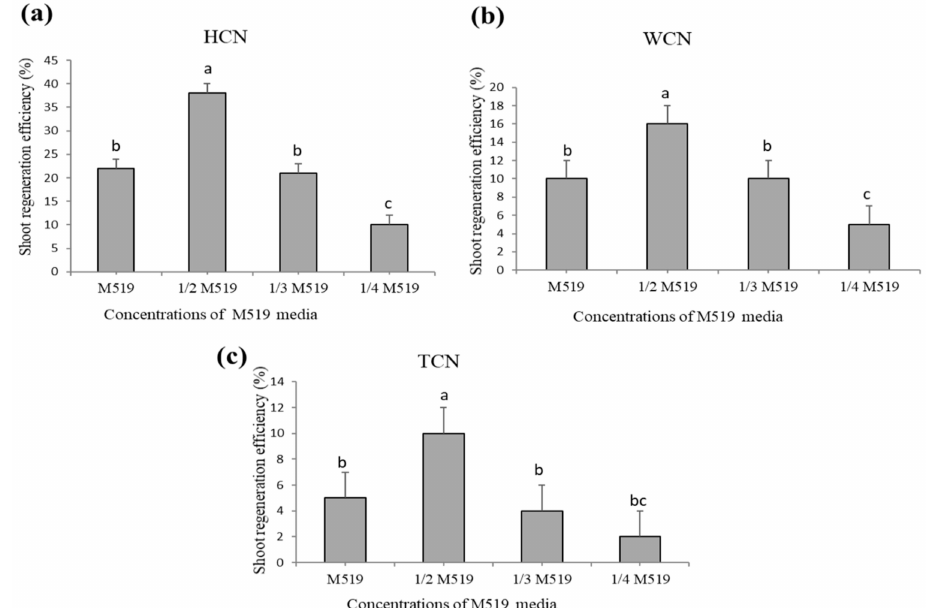
Figure 2. Shoot regeneration e ffi ciency of Lupinus albus from three di ff erent explants on four di ff erent concentrations of basal media. ( a ) HCN (half cotyledonary node), ( b ) WCN (whole cotyledonary node), ( c ) TCN (traditional cotyledonary node). HCN showed highest regeneration frequency and higher number of shoots on 1 M519 medium supplemented with (KT 4.0 mg L − 1 , NAA 0.1 mg L − 1 ), than WCN 2 and TCN. Di ff erent letters show significant di ff erences at p 0.05. Data shown represent mean ± standard error of four